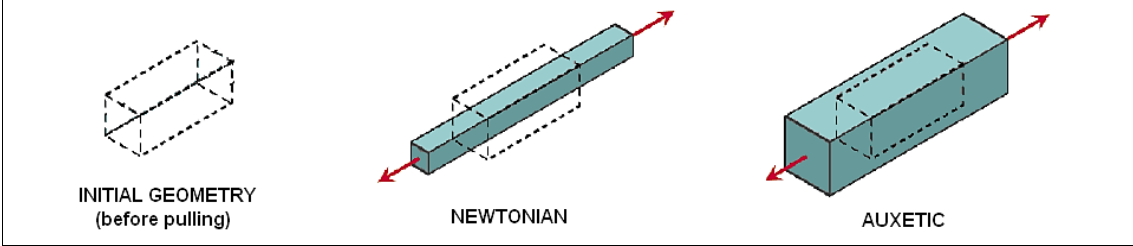
Figure 1. Compared tensile behaviour of Newtonian and auxetic material